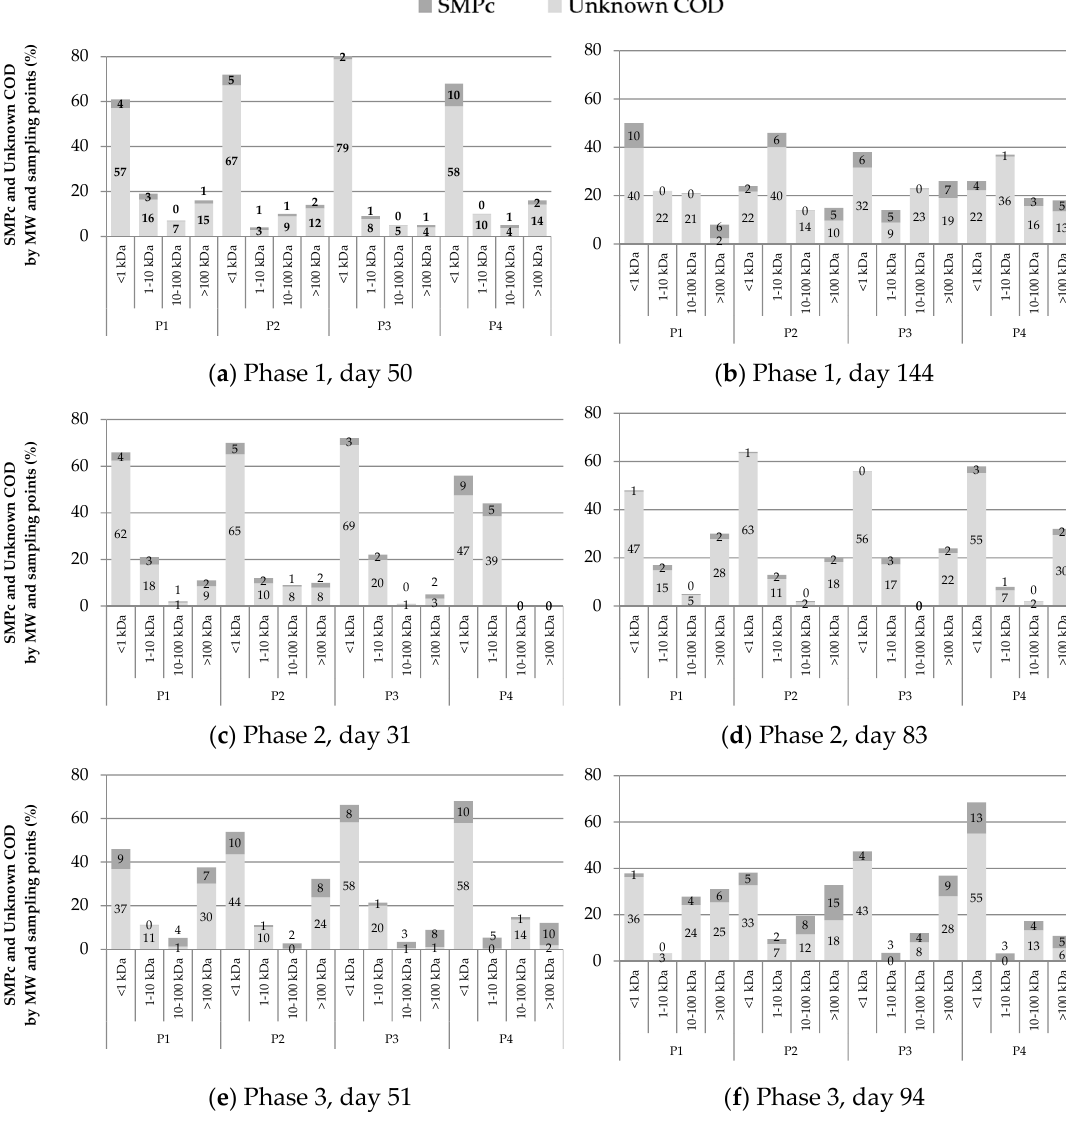
Figure 5. SMP percentages as unknown chemical oxygen demand (COD) and carbohydrates according to molecular weight distribution at each sample point. ( a , c , e ) correspond to the first ultrafiltration performed (day 50, 31, and 51 for phases 1, 2, and 3, respectively), and ( b , d , f ) are the ultrafiltration done at the end of operational phases 1, 2 and 3 (day 144, 83 and 94, respectively).